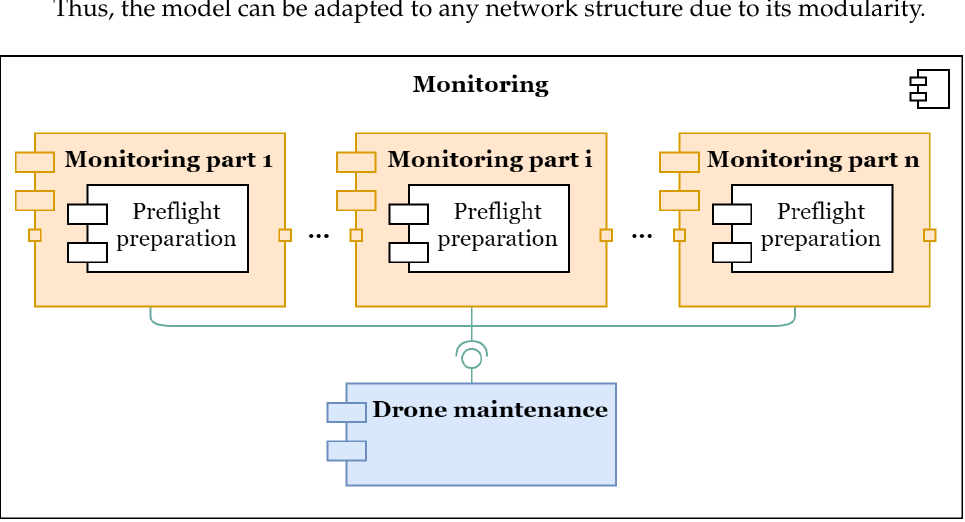
Figure 2. The component diagram of the monitoring model. The component diagram of the monitor- ing model shows that the drone’s area of responsibility at a particular monitoring object is divided into sections, depending on the possible take-off and drone landing points. Each section is modelled as a separate monitoring module, and they are all linked together in a chain. Furthermore, the monitoring modules are linked to the drone maintenance module, where the components of each drone are modelled in